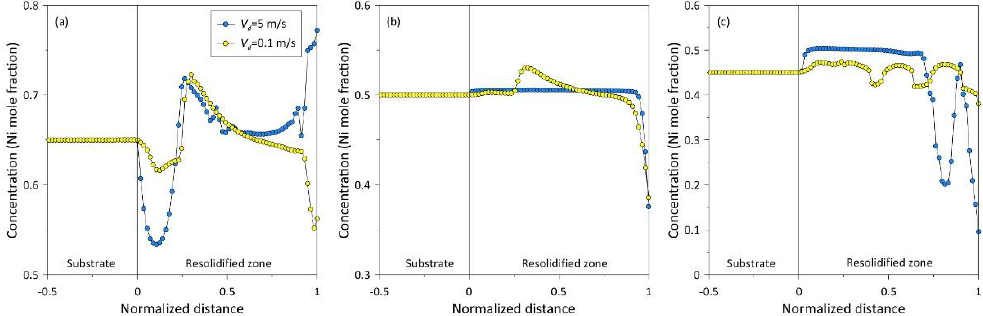
Figure 5. Concentration profile along the centreline of the melt pool for various diffusive speeds and initial compositions: ( a ) x = 0.65 ( b ) x = 0.50 Ni and ( c ) x = 0.45 mole fraction of Ni.